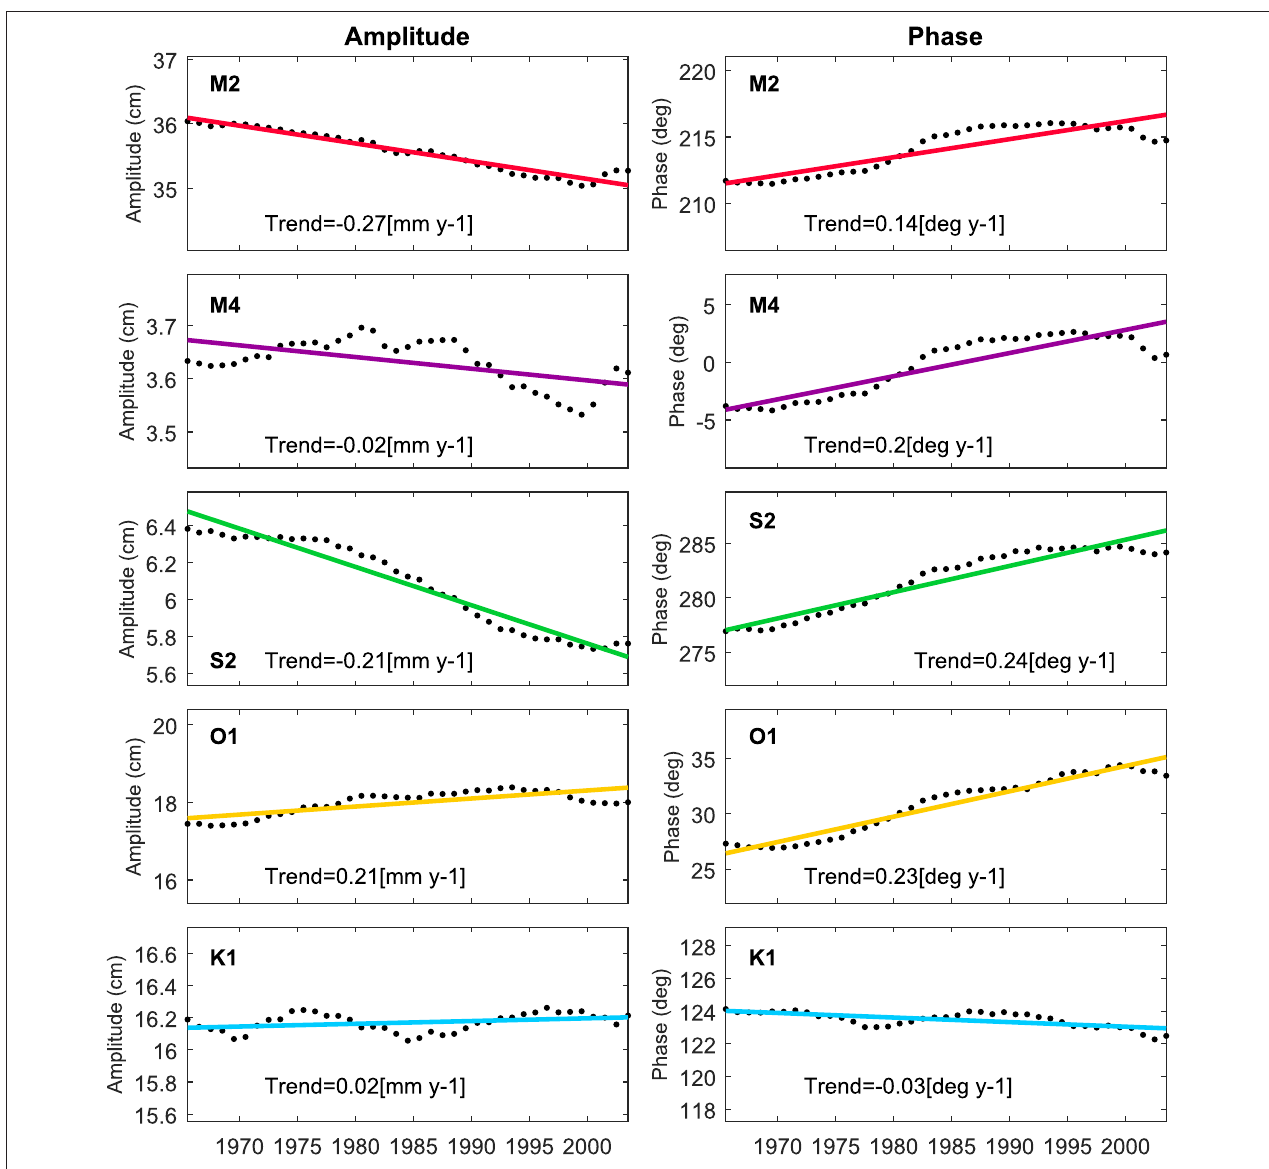
FIGURE 7 | Variability of amplitude and phase of the main tidal constituents of Mar del